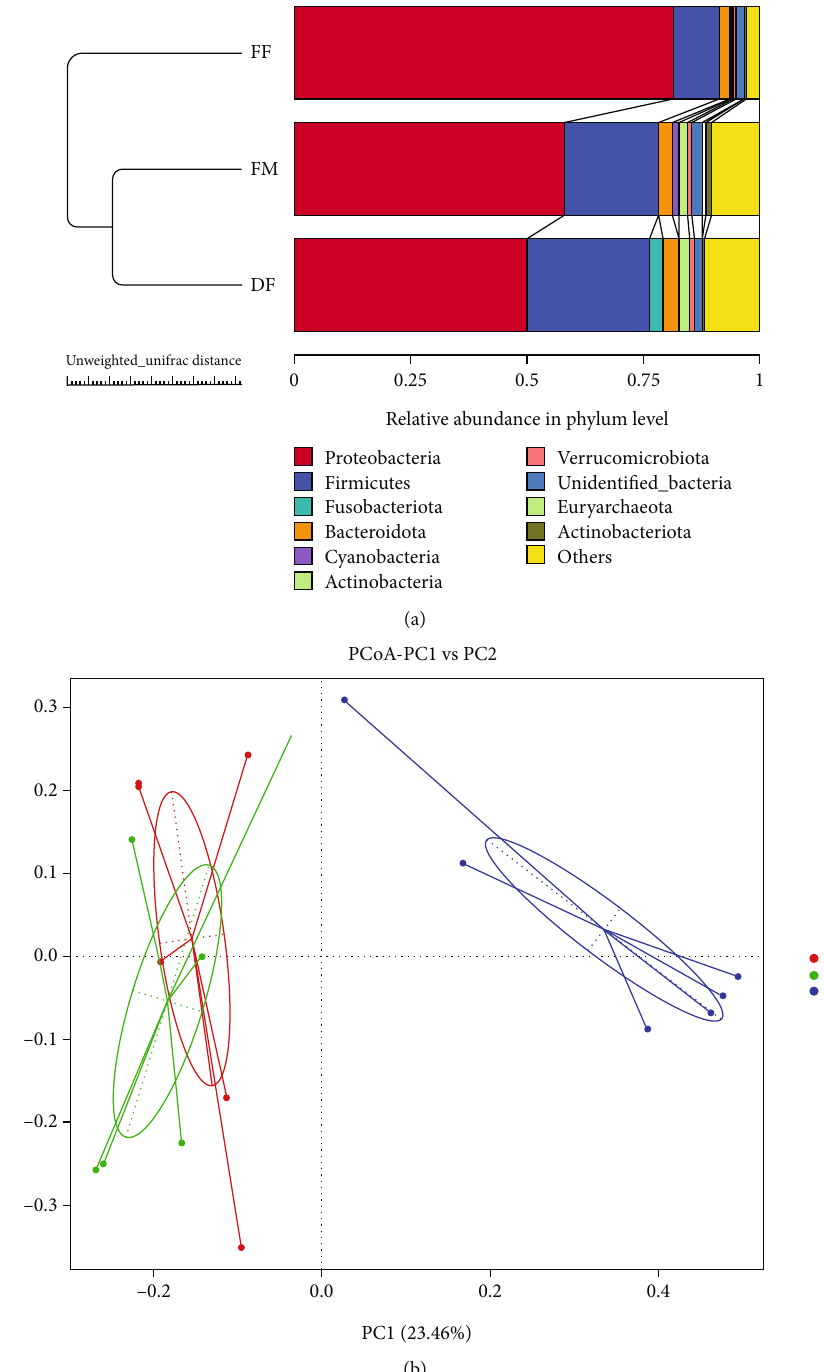
Figure 5: Beta diversity of intestinal microbiota of turbot. (a) Group UPGMA clustering tree. (b) PCoA